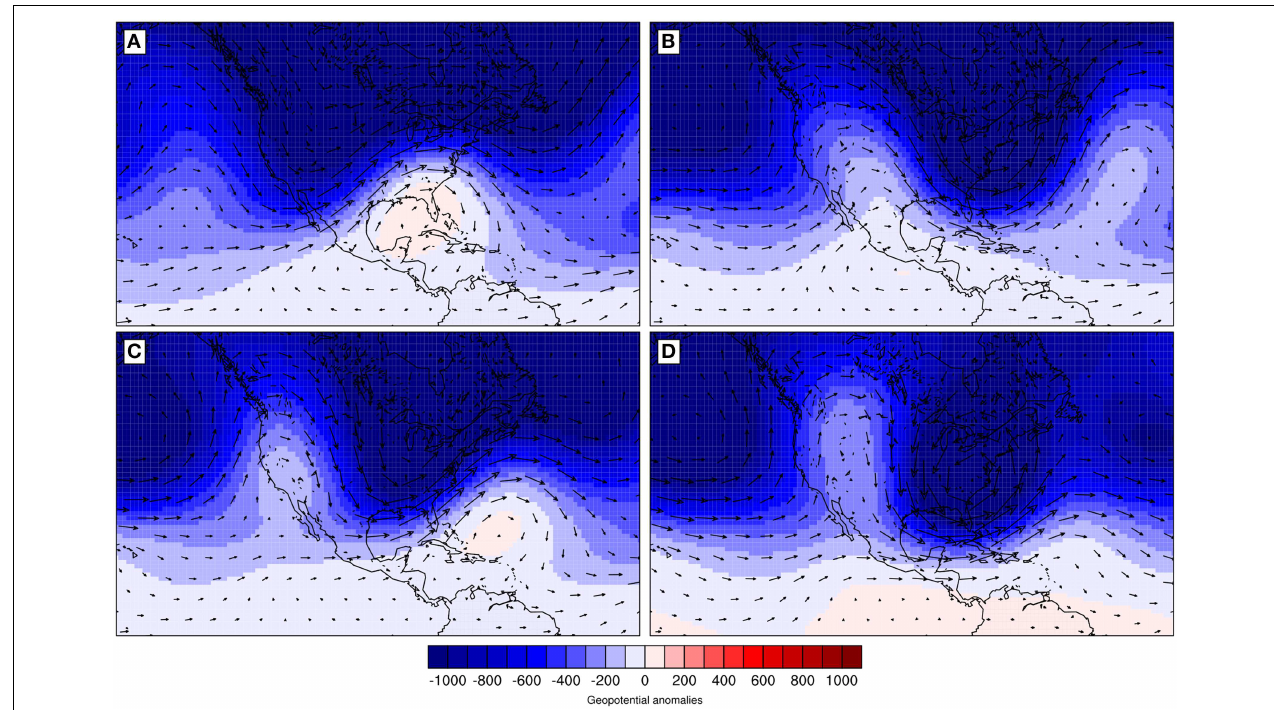
FIGURE 4 | Composited large-scale anomalies at 500 hPa associated with (A) WNEW, (B) WNCS, (C) WGCS, and (D) WNWS regimes. Geopotential anomalies (colored pixels) and anomalous wind field